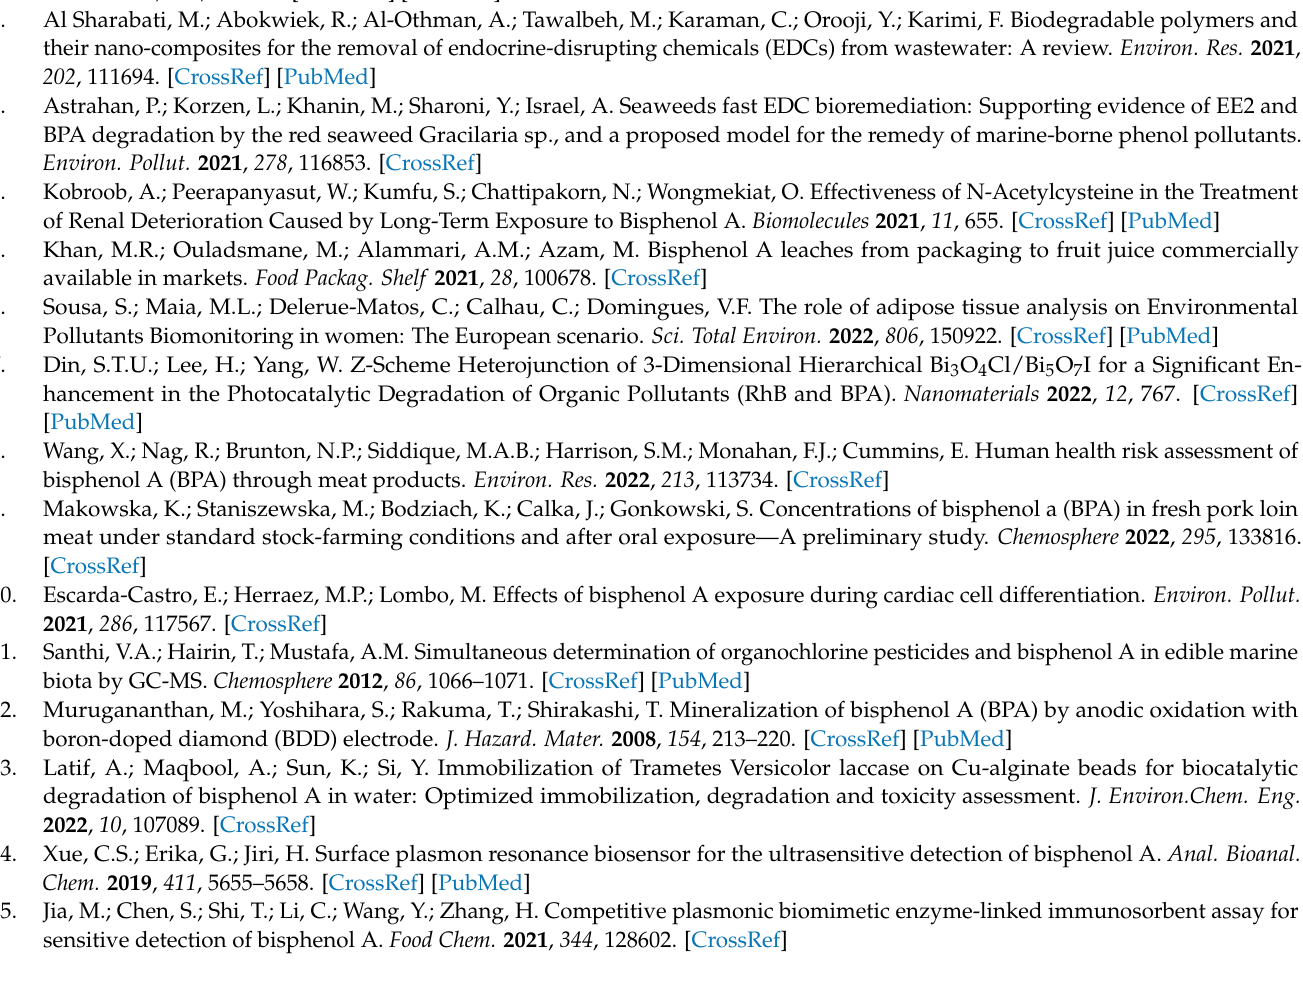
hollow spheres; Figure S2: Magnetic hysteresis ( M-H ) loops of Fe 3 O 4 hollow spheres, FA, FA@Ag and CSSN NCs (The inset is photograph of CSSN NCs dispersed in deionized water before and after magnet separation); Figure S3: Full XPS spectra of Fe 3 O 4 hollow spheres, FA, FA@Ag and CSSN NCs; Figure S4: UV-Vis spectra of BPA azo products, FA, FA@Ag and CSSN NCs; Table S1: Mössbauer spectrum parameters of Fe 3 O 4 hollow spheres; Table S2: Band assignments in the SERRS spectra of BPA azo